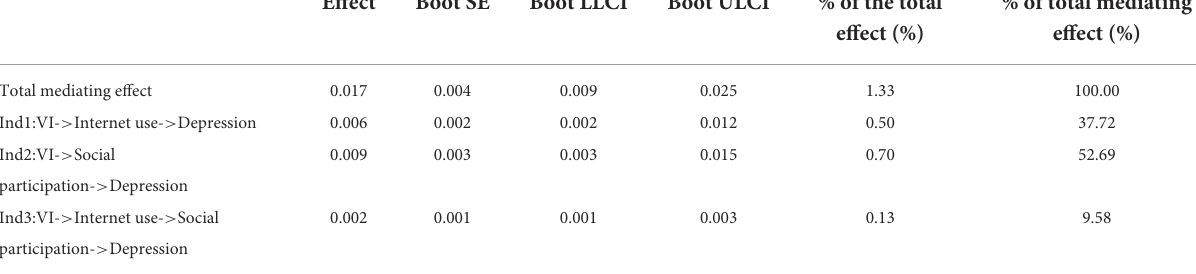
TABLE 3 The proportion of mediating